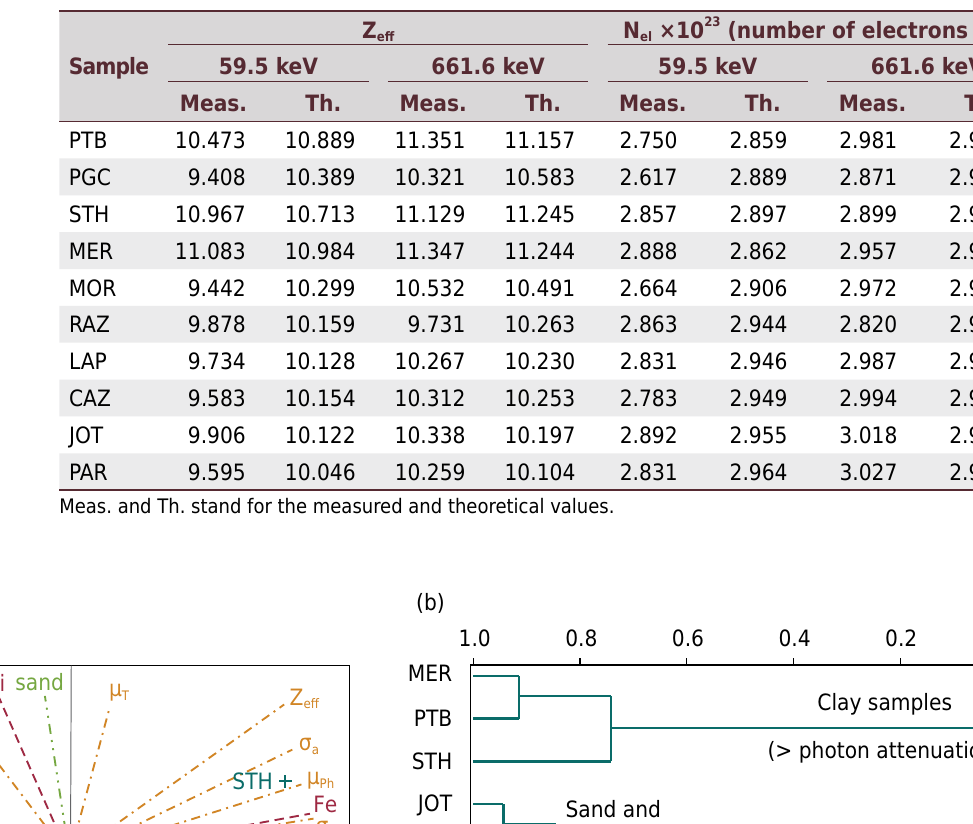
Table 5. Effective atomic number (Z eff ) and electron density (N el ) of the samples studied for the 241 Am and 137 Cs radioactive sources